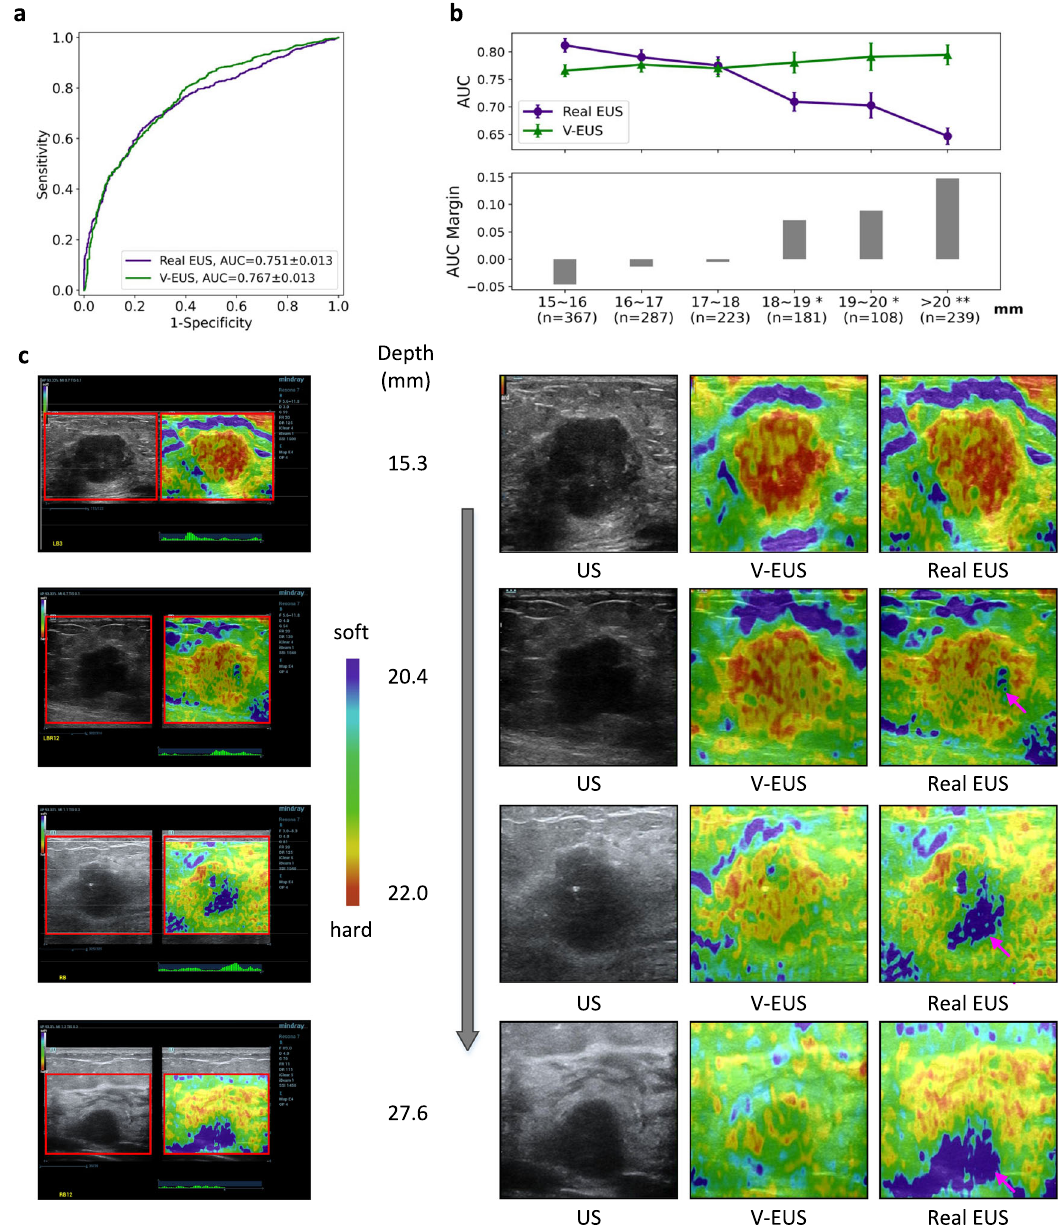
Fig. 4 | Dependence of V-EUS on tumor depth in diagnosing breast cancer. a Comparison of ROCsindetermining tumor malignancyontest setwhendividing training and test set with15mm asthe threshold. b The diagnosticperformanceof real EUS and V-EUS varies with the depth of tumor. For the realEUS, the centersof the error bar for each interval are 0.812, 0.790, 0.775, 0.709, 0.702, and 0.647, respectively. Forthe V-EUS,the centersofthe errorbar for eachinterval are0.766, 0.777,0.770,0.781,0.791and0.794respectively.nindicatesthenumberofcasesin